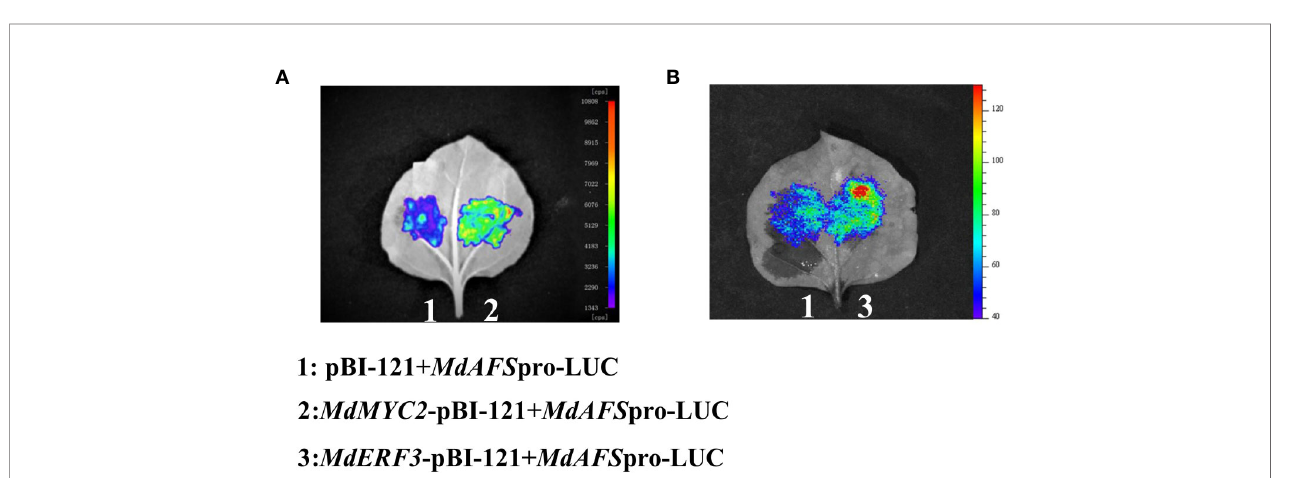
FIGURE 2 | The fi re fl y luciferase (Luc) complementation imaging assays. Agrobacterium GV3101 strain harboring different constructs was in fi ltrated into tobacco leaves. Luminescence signals in the in fi ltrated region were measured 48 h after in fi ltration. (A) 1: pBI-121+MdAFSpro-LUC, 2: MdMYC2-pBI-121+MdAFSpro-LUC. (B) 1: pBI-121+MdAFSpro-LUC, 2: